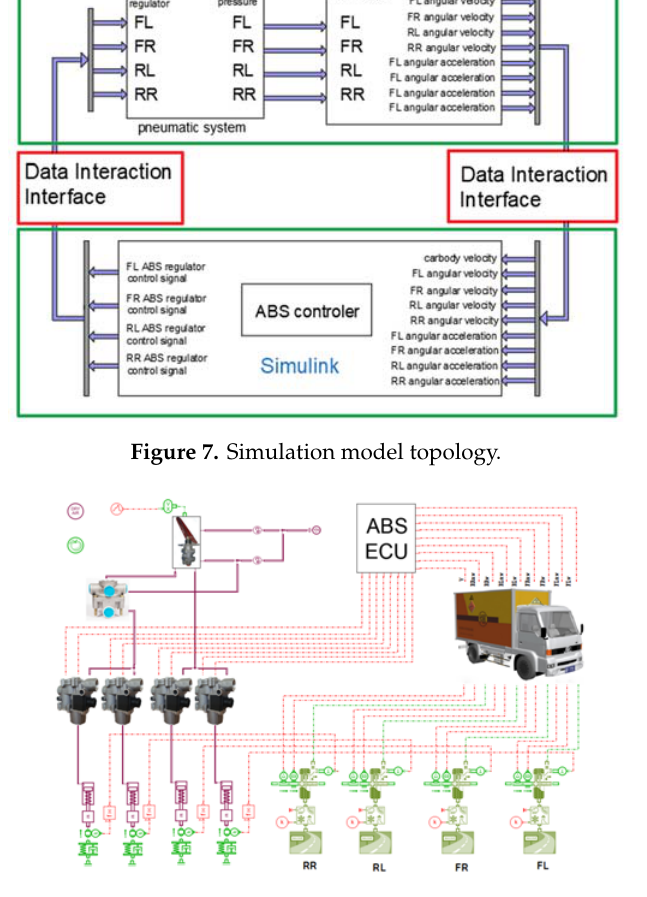
Figure 8. Total model of simulation.